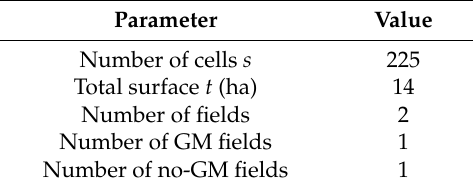
Table 2. Parameters defining the homogeneous and unconstrained landscape.